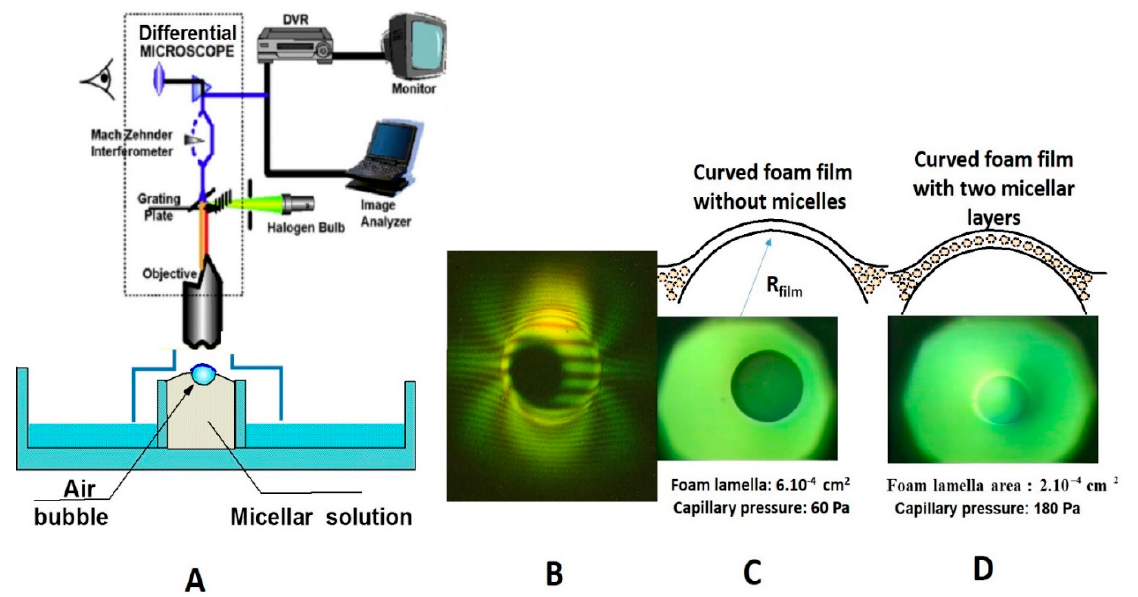
Figure 6. ( A ) Sketch of the optical arrangement to monitor the micellar foam’s multiple stepwise thinning phenomena using the film’s capillary force balance, via the ring method. ( B ) Foam film’s thinning interferogram of the micellar solution of cetyltrimethylammonium bromide (CTAB) at a concentration of 2.10 − 1 M depicts the stepwise thickness transitions [31]. Reprinted with permission from [31]. Copyright 2022 Elsevier.